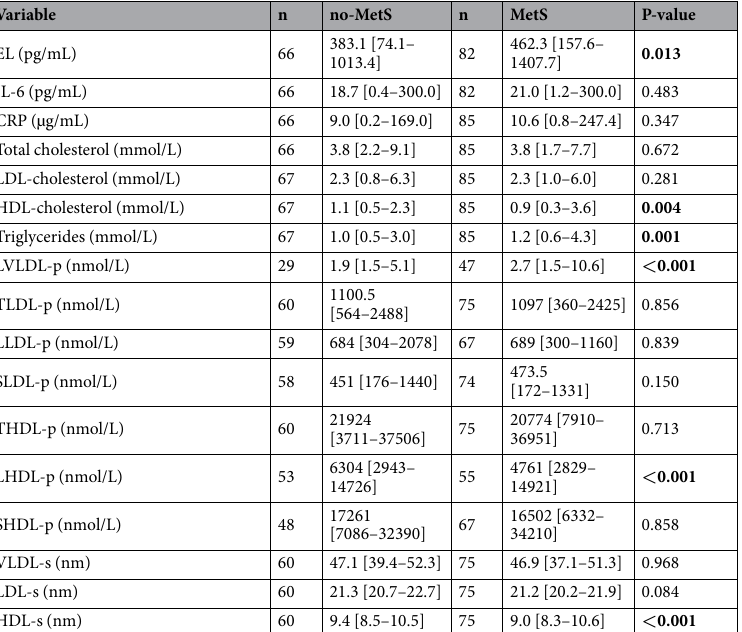
Table 2. Laboratory parameters. Results are presented as median, minimum and maximum. Significant differences between MetS and noMetS patients were calculated with Mann-Whitney U-test and are depicted in bold. HDL-high density lipoprotein; LDL-low-density lipoprotein; IL-6-interleukin 6; hsCRP-C-reactive protein; EL-endothelial lipase; LVLDL-p –large very low-density lipoprotein particles; TLDL-p –total LDL particles; LLDL-p –large LDL particles; SLDL-p –small LDL-p; THDL-p –total HDL-particles; LHDL-p –large HDL-p; SHDL-p –small HDL-p; VLDL-s –VLDL size; LDL-s –LDL size; HDL-s –HDL size; n- number of samples in which particular parameter was analysed. Reference values: Triglycerides (mmol/L) 0.5–1.8 (male); 0.5–1.5 (female); total cholesterol (mmol/L) 3.5–5.2; HDL-cholesterol (mmol/L) ≥ 1.4 (male); ≥ 1.7 (female); LDL-cholesterol (mmol/L) 2.0–3.9. a SI measurements. To convert to mg/dL, multiply Triglycerides by 89 and total cholesterol, HDL-cholesterol or LDL-cholesterol by 39.